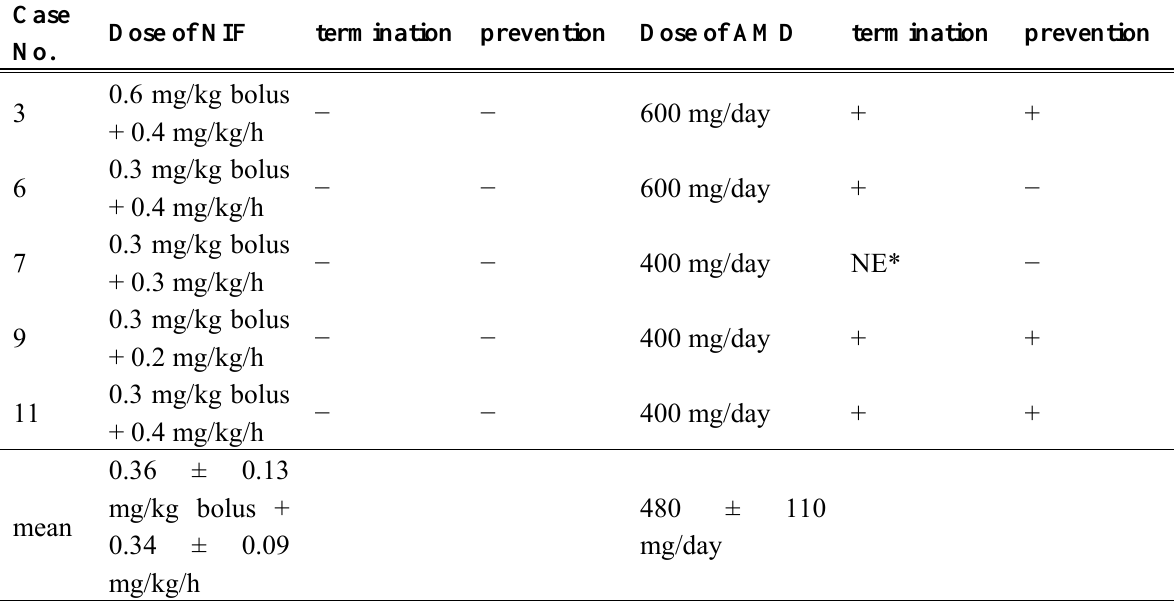
Table 3. Effects of class III drugs on atrial